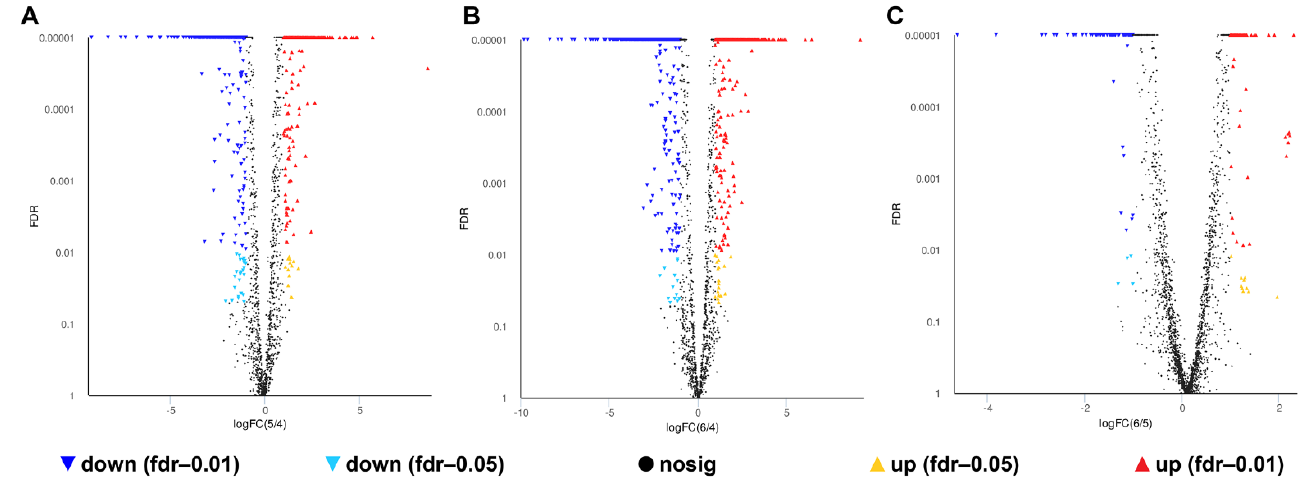
Figure 4 . Volcano plot of genes. The red and green data points indicate upregulated and downregulated DEGs, respectively. ( A ): 0% NaCl vs. 10% NaCl; ( B ): 0% NaCl vs. 20% NaCl; ( C ): 10% NaCl vs. 20% NaCl.